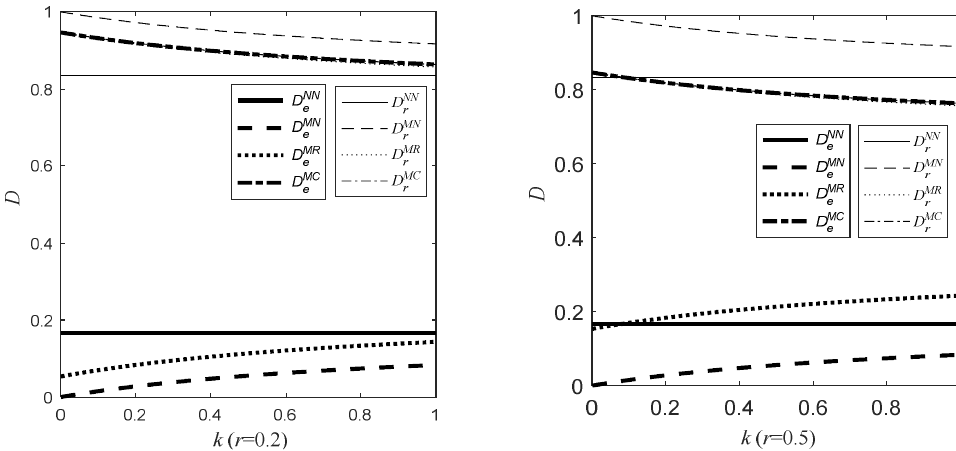
Figure 1. The impact of the proportion of residual value on optimal demand after the diminution of the value of the returned product per unit.